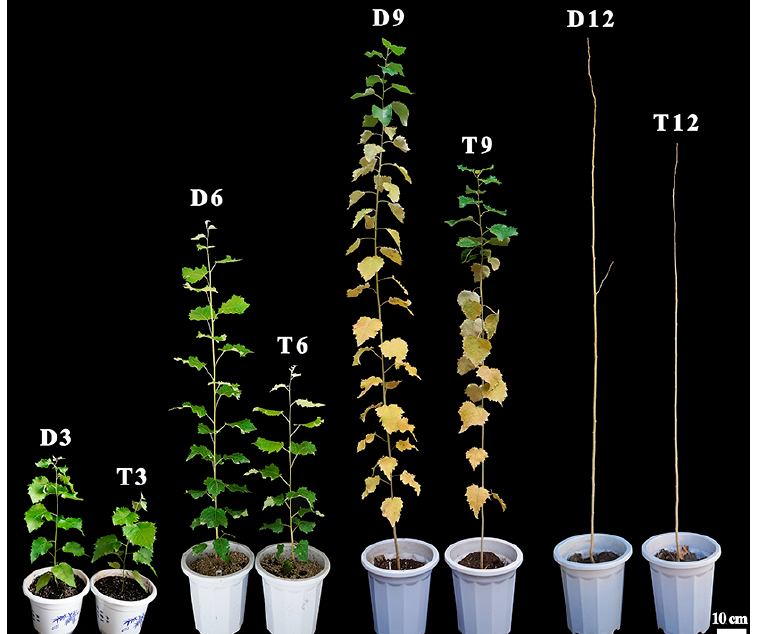
Figure 1. Morphological changes in diploid and tetraploid plants at di ff erent growth stages of P. hopeiensis clone BT1 . D3, D6, D9, and D12 correspond to 3-, 6-, 9-, and 12-month-old diploid P. hopeiensis , respectively. T3, T6, T9, and T12 correspond to 3-, 6-, 9-, and 12-month-old tetraploid P. hopeiensis , respectively.